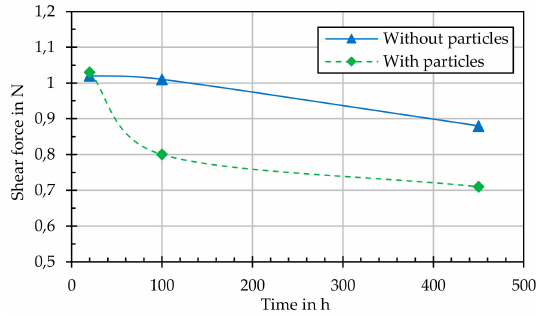
Figure 11. Determination of the bond hardness between substrate and